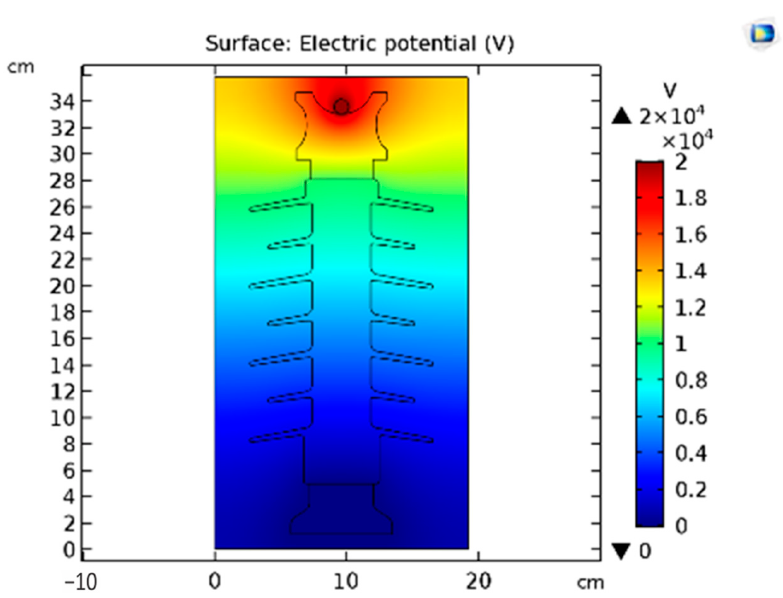
Figure 11. Voltage distribution in polymer insulators.